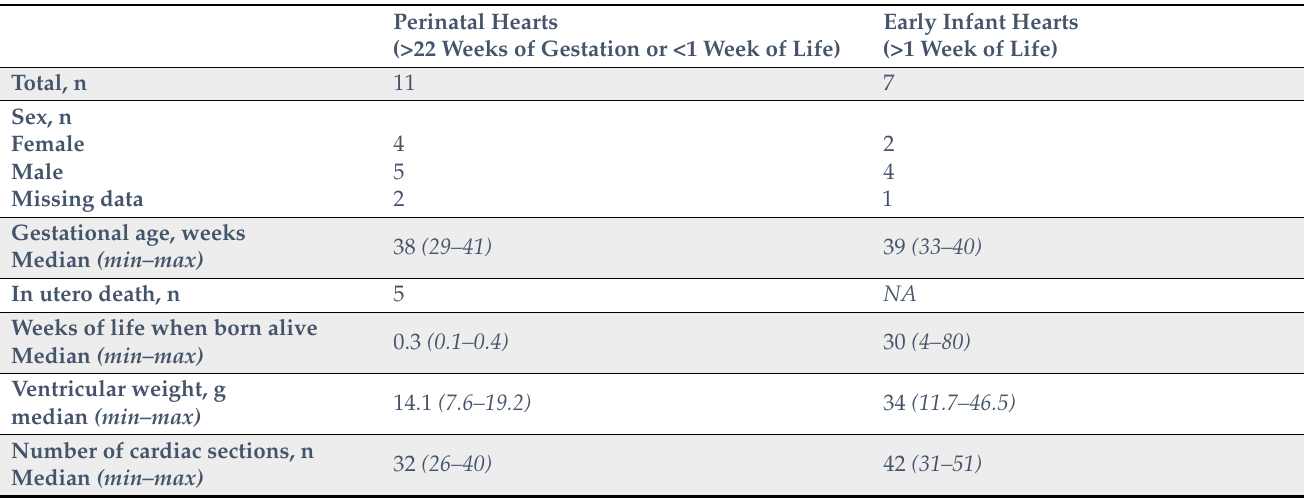
Table 1. Anthropometric